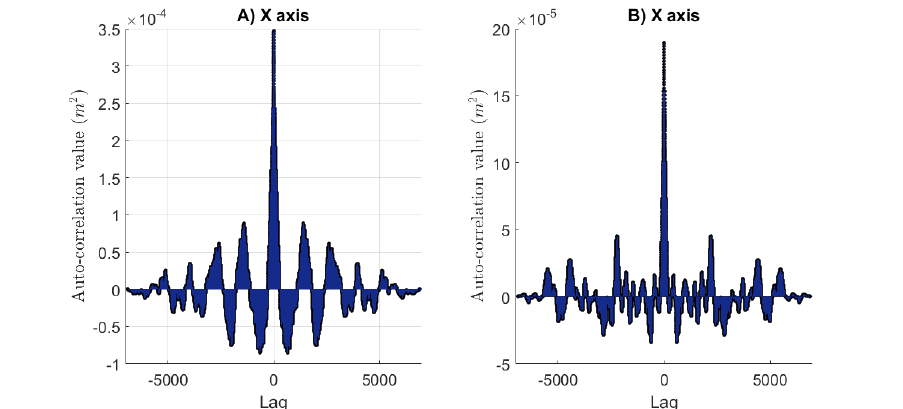
Figure 14. Plots of the autocorrelation functions of the residuals for each axis X and Y .